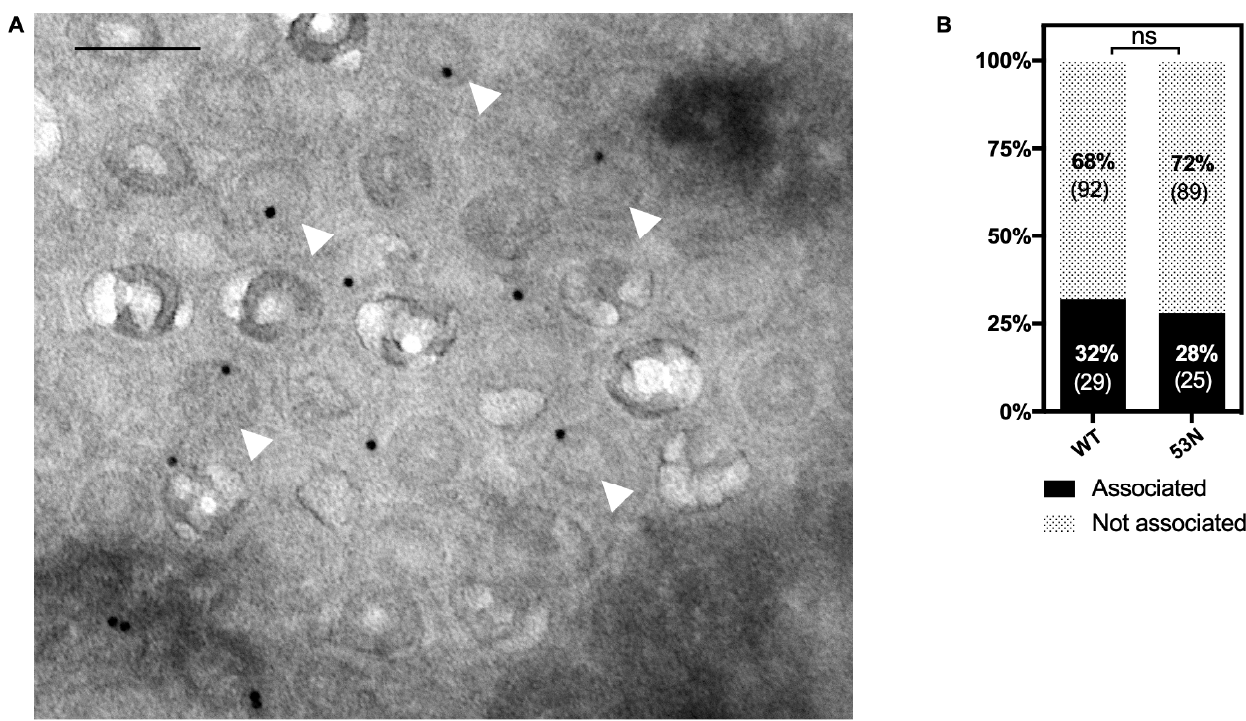
Figure 6. HFFs were infected with either WT or 53N HCMV (MOI 1) and fixed for immunoEM at 72 hpi. The cells were further processed by primary staining with α -myoVa followed by secondary staining with 10-nm protein A-gold. Imaging was conducted using a transmission electron micro- scope. ( A ) shows a representative image of the 53N condition. White arrowheads indicate capsids that are associated with myoVa. Scale bar is 100 nm. ( B ) The percentage of capsids associated with at least one gold particle was calculated for each condition (WT, n = 121; 53N, n = 144). The p value was calculated using Fisher’s exact test (ns = not significant, p = 0.76).